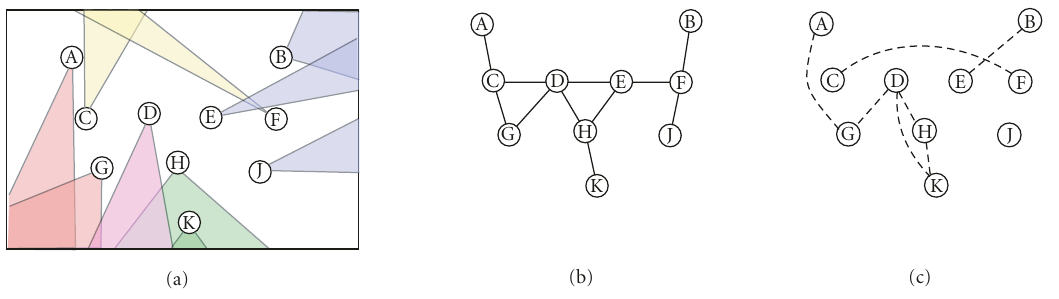
Figure 1: (a) A snapshot of the instantaneous state of a camera network, indicating the fields of view of ten cameras. (b) A possible commu- nication graph. (c) The associated vision